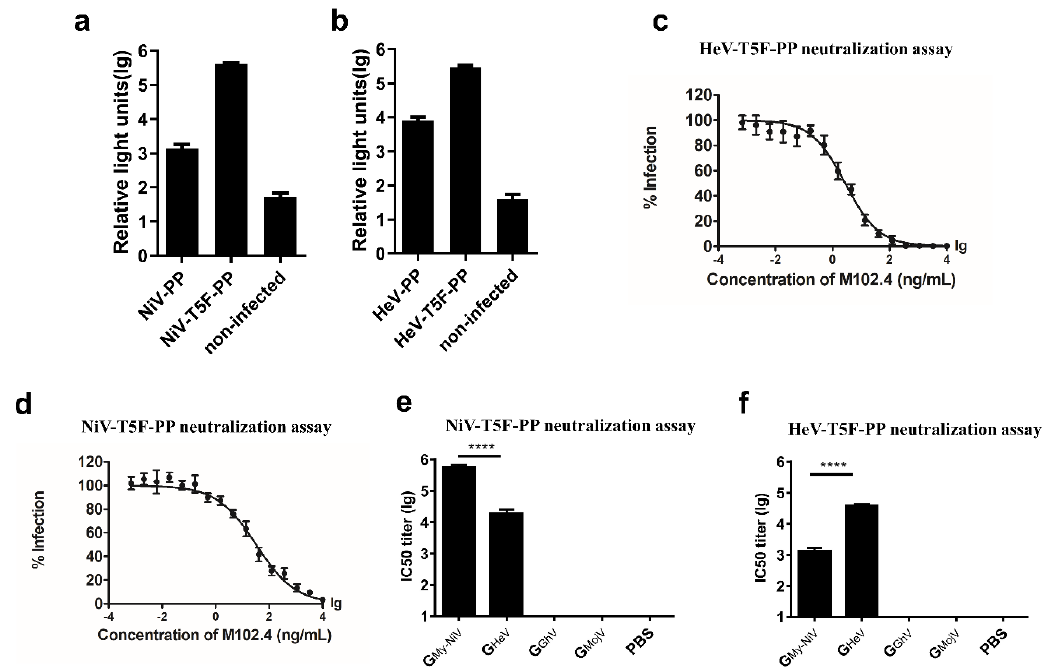
Figure 4. Packaging and verification of the NiV and HeV pseudoviruses. Codon-optimized, full-length G and F protein genes of NiV and HeV were inserted into the pcDNA3.1 vector to generate synthetic viral proteins. For the NiV-PP, the sequences of the G (Genebank protein ID: AAY43916.1) and F (AAY43915.1) proteins were used; for the HeV-PP, the sequences of the G (AEQ38071.1) and F (AEQ38070.1) proteins were used. By truncating the pcDNA3.1-NiV-F plasmid, 5 amino acids in the C-terminal intracellular region of the F protein were retained; the pseudovirus made by the truncated F plasmid was named NiV-T5F-PP. By truncating the pcDNA3.1-HeV-F plasmid, 5 amino acids in the C-terminal intracellular region of the F protein were retained; the pseudovirus made by the truncated F plasmid was named HeV-T5F-PP. ( a ) Effect of the truncation of the F proteins on the NiV pseudovirus titer. Each point represents three duplicates, and the error bar represents SEM. ( b ) Effect of the truncation of the F proteins on the HeV pseudovirus titer. ( c ) HeV pseudovirus-neutralizing experiment using M102.4. Each point represents three duplicates, and the error bar represents SEM. ( d ) NiV pseudovirus-neutralizing experiment using M102.4. ( e ) NiV pseudovirus-neutralizing experiment. ( f ) HeV pseudovirus-neutralizing experiment. The data are presented as the mean log10 IC50 ± SEM. Student’s t test was performed for all comparisons, and a P -value < 0.05 was considered statistically significant; **** P -value < 0.0001.